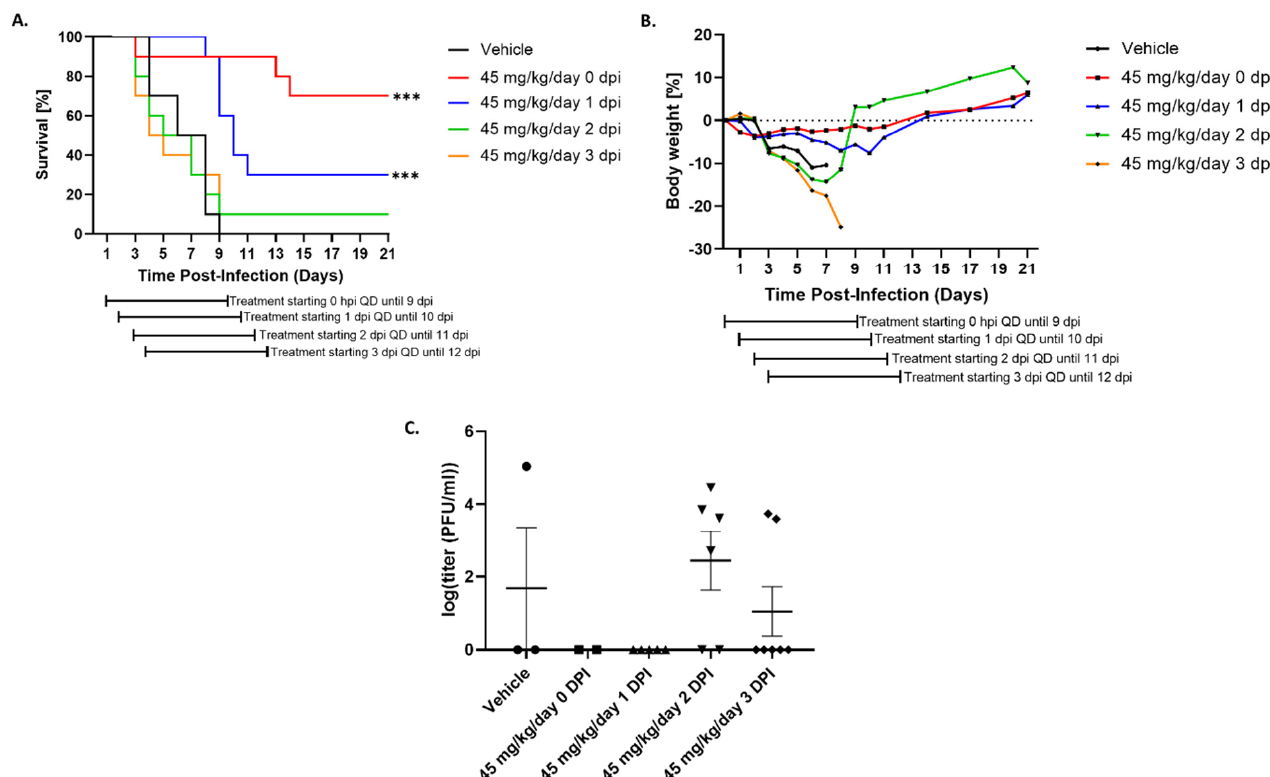
Figure 4. Therapeutic efficacy of Tilorone against RVFV infection in BALB/c mice. Mice (n = 10/group) were infected with 100 PFU RVFV ZH501 via the intraperitoneal (i.p.) route. Treatment of Tilorone was initiated immediately after infection, 1 DPI, 2 DPI, or 3 DPI. Tilorone at 45 mg/kg/day or vehicle was administered once daily via the IP route for 8 consecutive days after initiation of treatment. ( A ) Survival of animals receiving Tilorone or vehicle. ( B ) Percent weight change of animals receiving Tilorone or vehicle. ( C ) Terminal viremia for euthanized moribund animals receiving Tilorone or vehicle. *** p < 0.001.